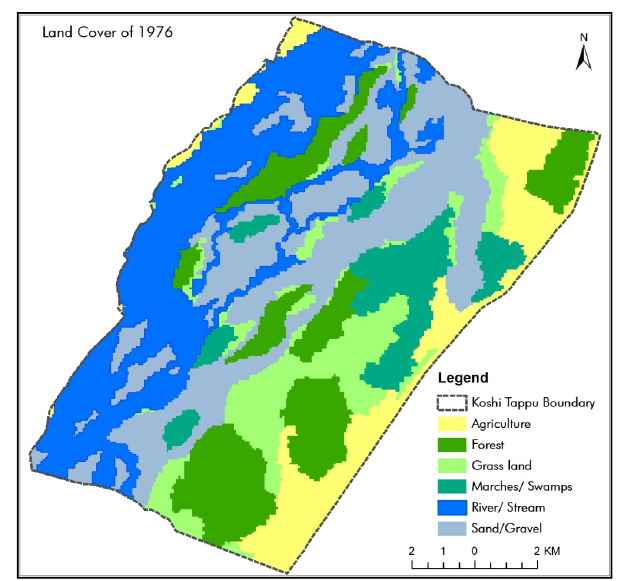
Figure 3. Sets of maps showing land use and cover changes in the Koshi Tappu Wildlife Reserve during 1976 to 2010. ( a ). Land cover in KTWR 1976; ( b ). Land cover in KTWR 1989; ( c ). Land cover in KTWR 1999; ( d ). Land cover in KTWR 2010. ( a